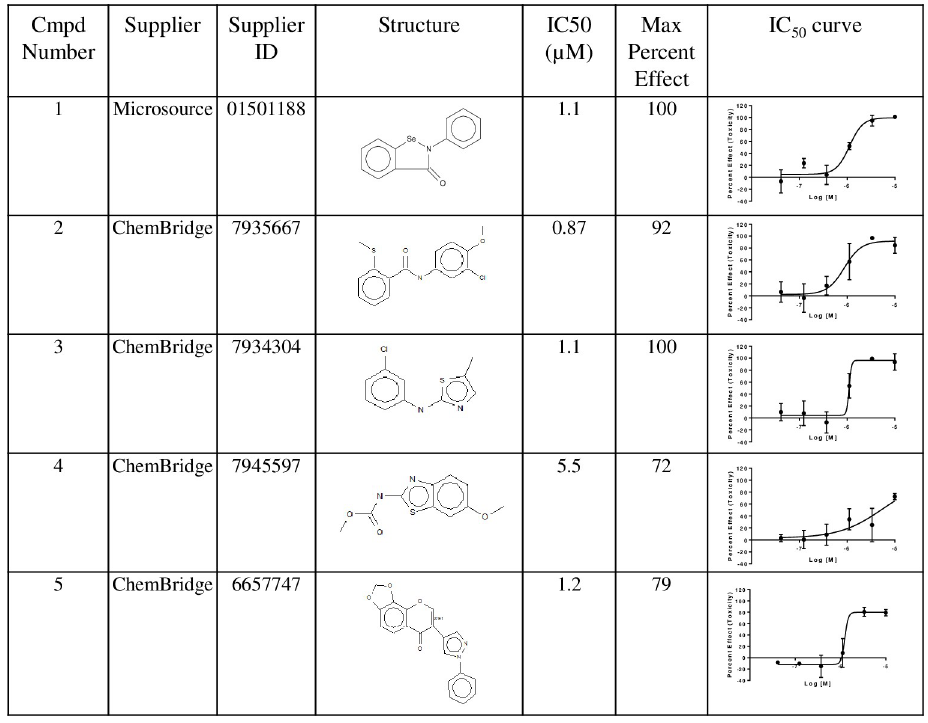
runs (https://doi.org/10.6084/m9.figshare.7971341.v1). As expected, known anthelmintics had